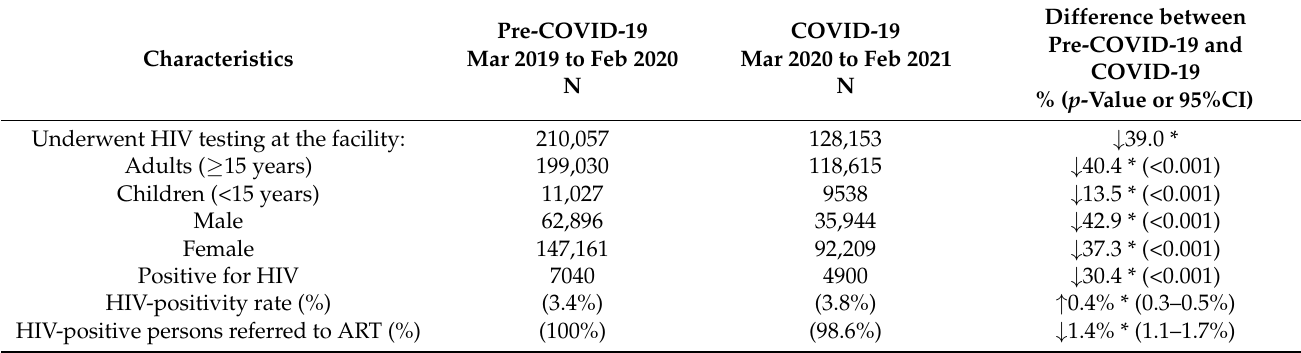
Table 3. Characteristics of persons tested for HIV and referred to antiretroviral therapy in eight health facilities in Lilongwe, Malawi, during the pre-COVID-19 and COVID-19 periods.